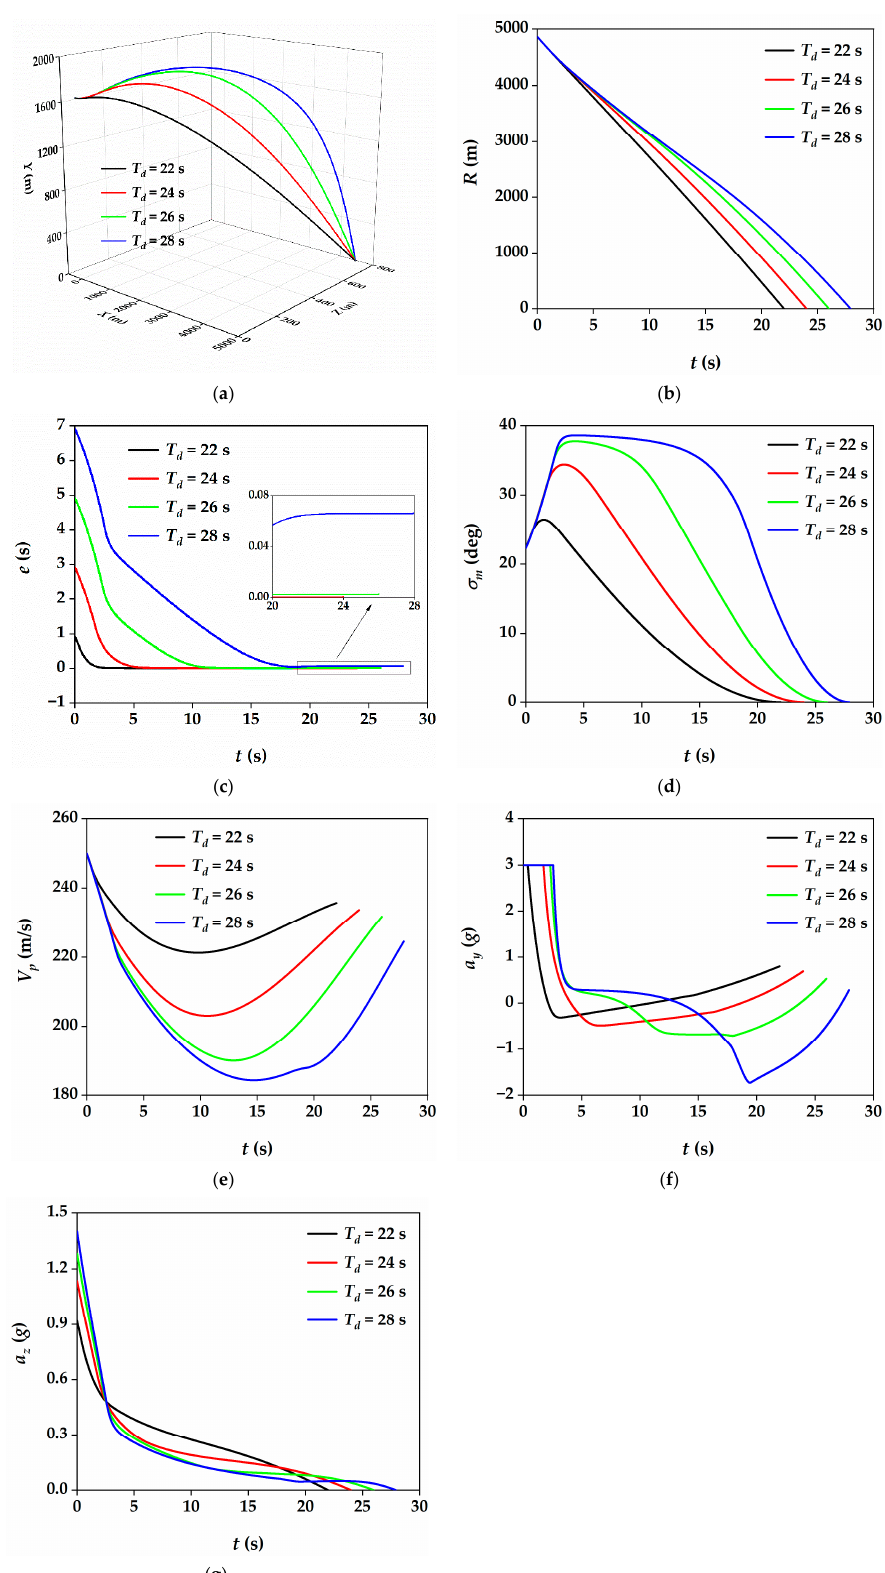
Figure 4. Simulation results under different T d . ( a ) Projectile flight trajectory; ( b ) relative distance; ( c ) impact time error; ( d ) lead angle; ( e ) velocity; ( f ) normal acceleration; ( g ) lateral acceleration.